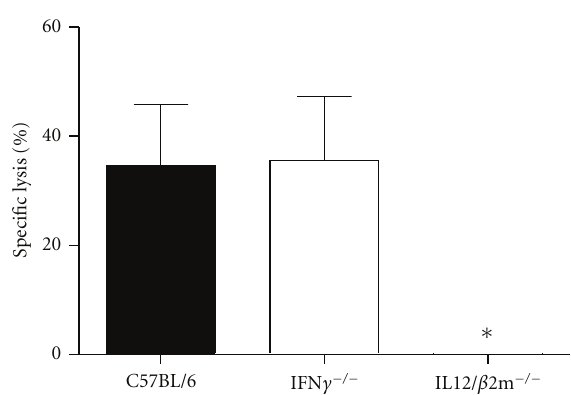
Figure 5: Lysis of B. abortus -infected macrophages by splenocytes from IFN- γ KO and C57BL/6 mice. Macrophages di ff erentiated (5 × 10 5 cells/well) obtained from IL-12/ β 2-m − / − , IFN- γ − / − , and C57BL/6 mice were infected with B. abortus (MOI 100 :1) and used as target cells. Splenocytes (1 × 10 6 cells/well) obtained from IL- 12/ β 2-m − / − , IFN- γ − / − , and C57BL/6 mice at one week of infection were used as e ff ector cells for cytotoxic assay and were cocultured with macrophages in 24 well plates in DMEM medium. E ff ector cells were added to target cells in duplicate at 2:1 ratio. Significant di ff erence in relation to C57BL/6 and IFN- γ KO mice is denoted by an asterisk ( P < 0.05). Results are means ± standard deviations of experiments performed. Data shown are representative of two di ff erent